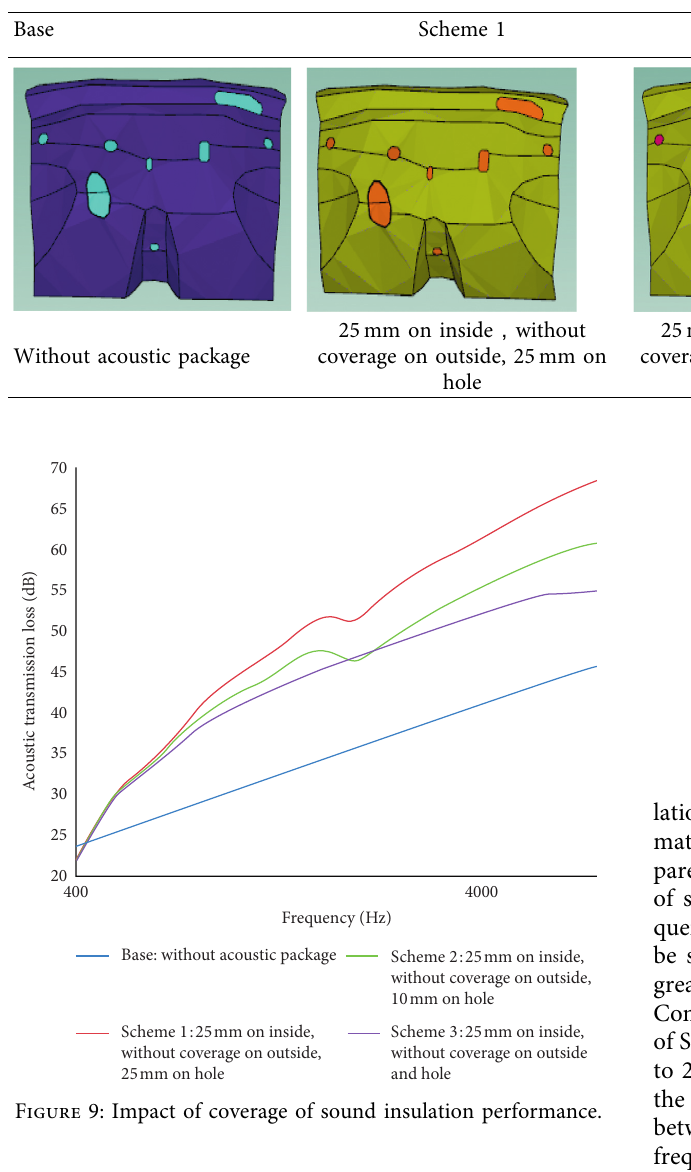
Table 4: Cover means of acoustic package.